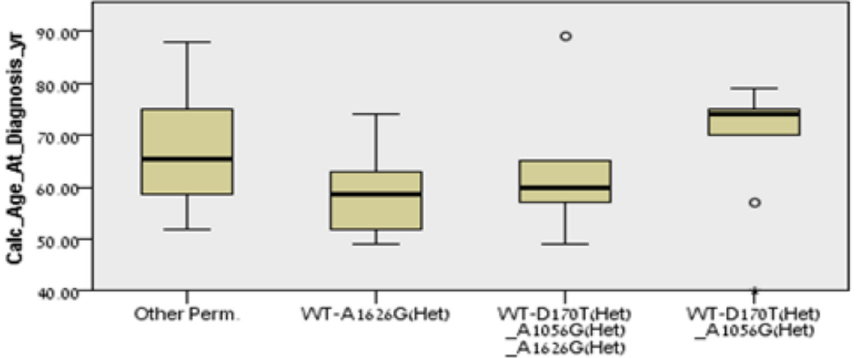
Fig 3. Independent samples Kruskal – Wallis test. Age differences between the patients with three predominant genotypes and the rest of the cohort.